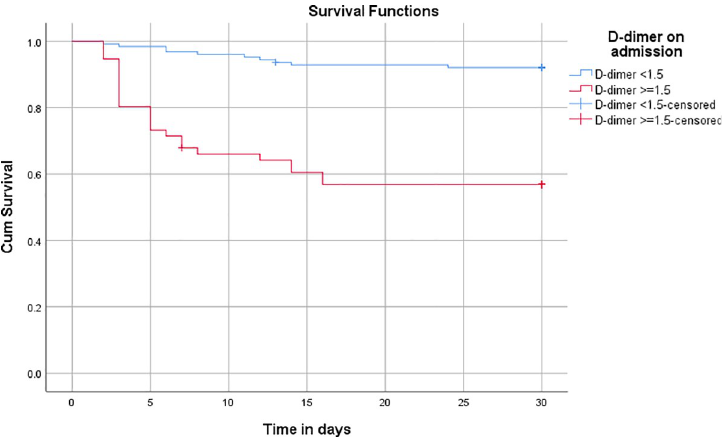
Fig 4. Survival analysis using the Kaplan Meier